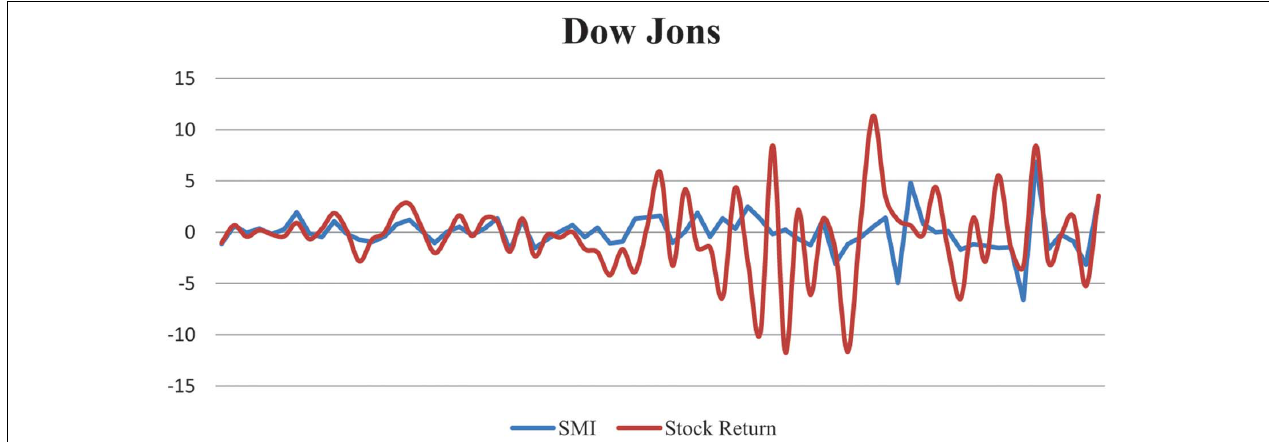
FIGURE 4 | Relationship between Dow Jones stock market returns and created Sentiment